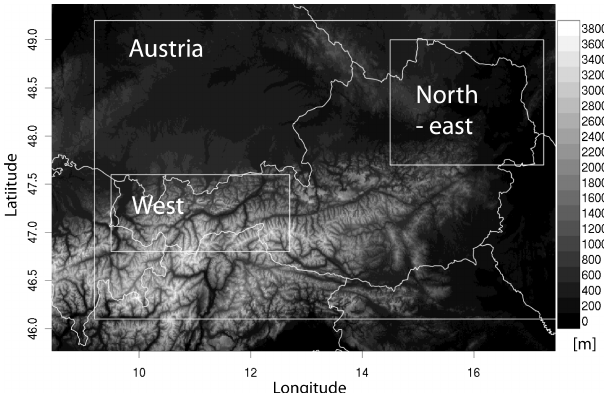
Figure 3. INCA domain and topography with the subdomains which are used for the